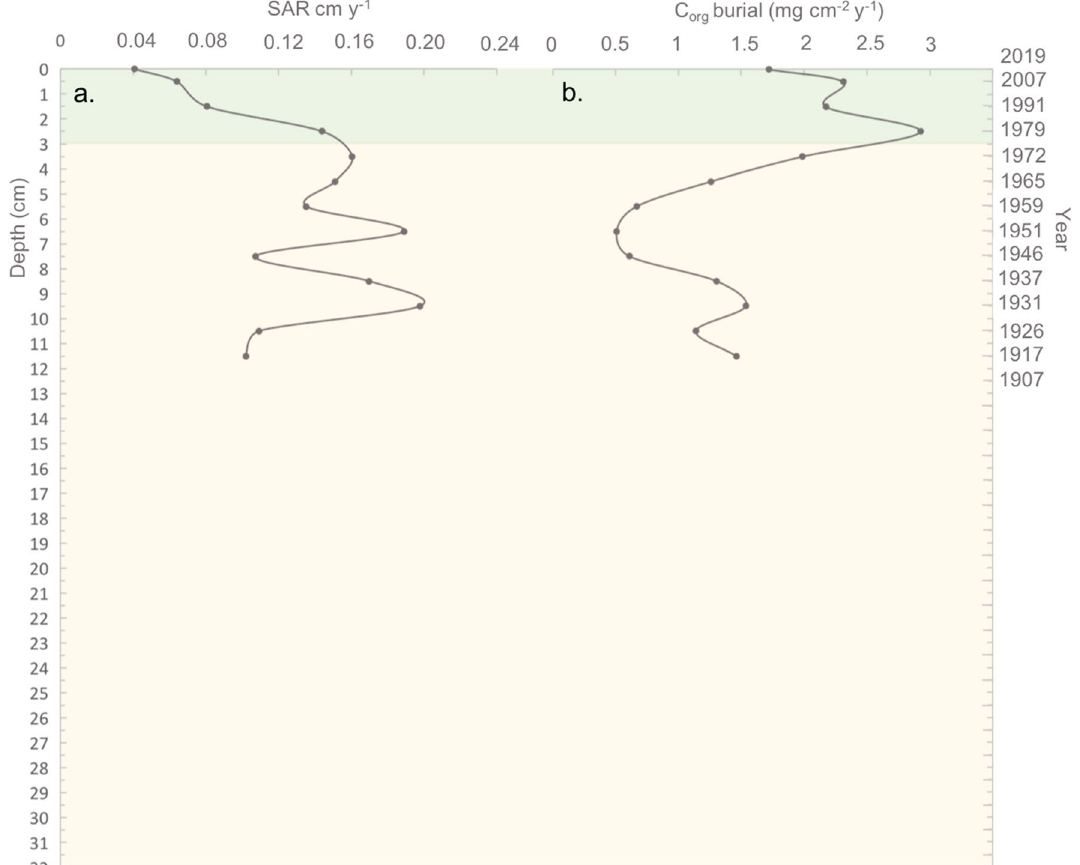
Figure 6. Changes in biogeochemical variables along sediment depth (left axis) and time (right axis) in the core BS2A1: ( a ) sediment accretion rate and ( b ) organic carbon burial rate. Green color indicates the period after the building of the bridge in